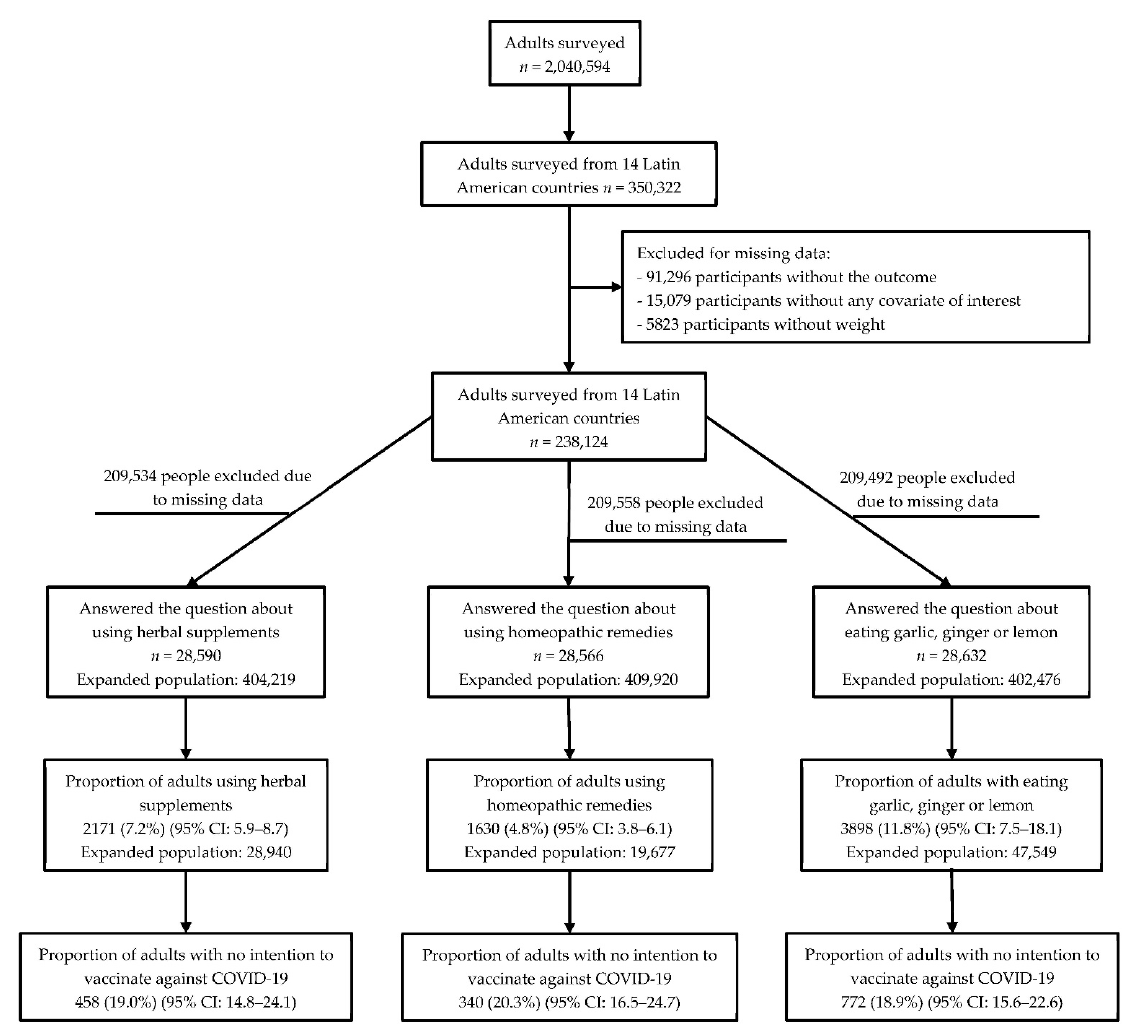
Figure 1. Flowchart of the selection of participants included in the analysis.